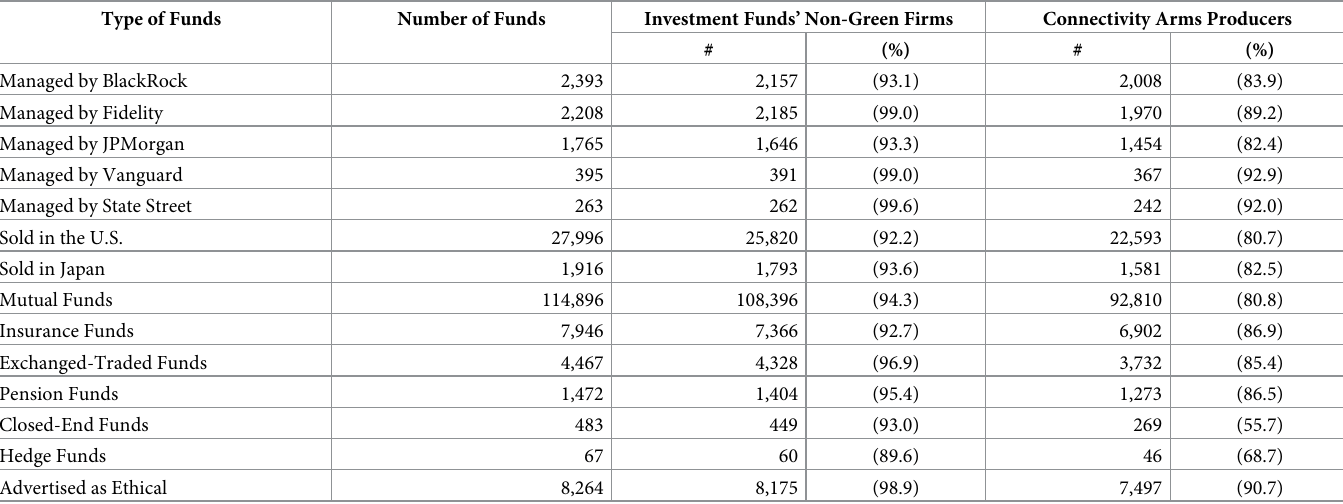
Table 5. Equity funds connectivity to non-ESG